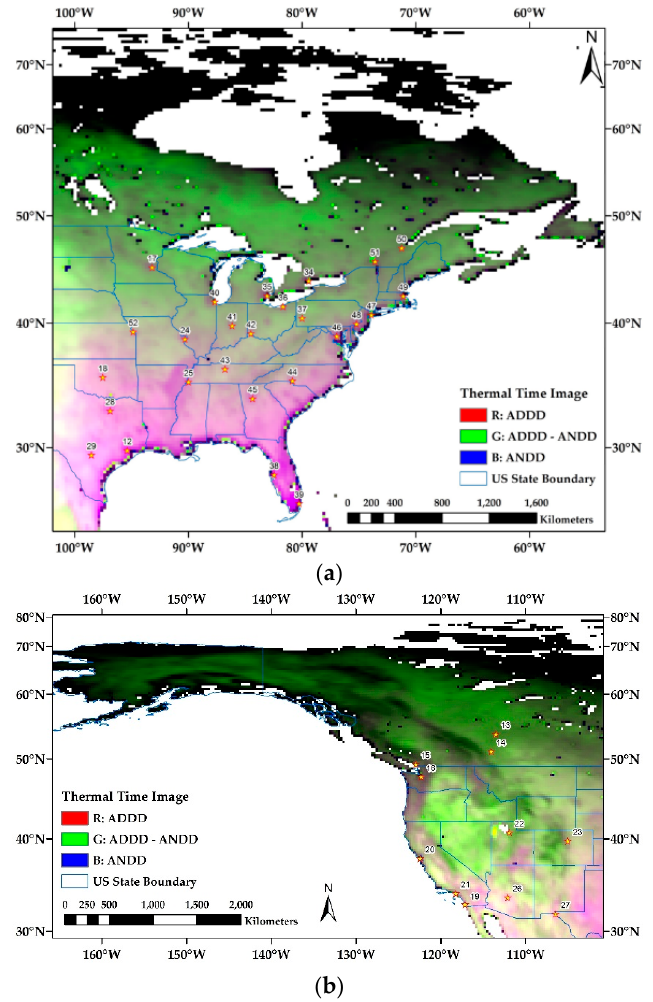
Figure 3. False-color composite of thermal time metrics for central-eastern Canada and the USA ( a ) and western Canada and the USA ( b ). Labels show urban identification numbers as presented in Table